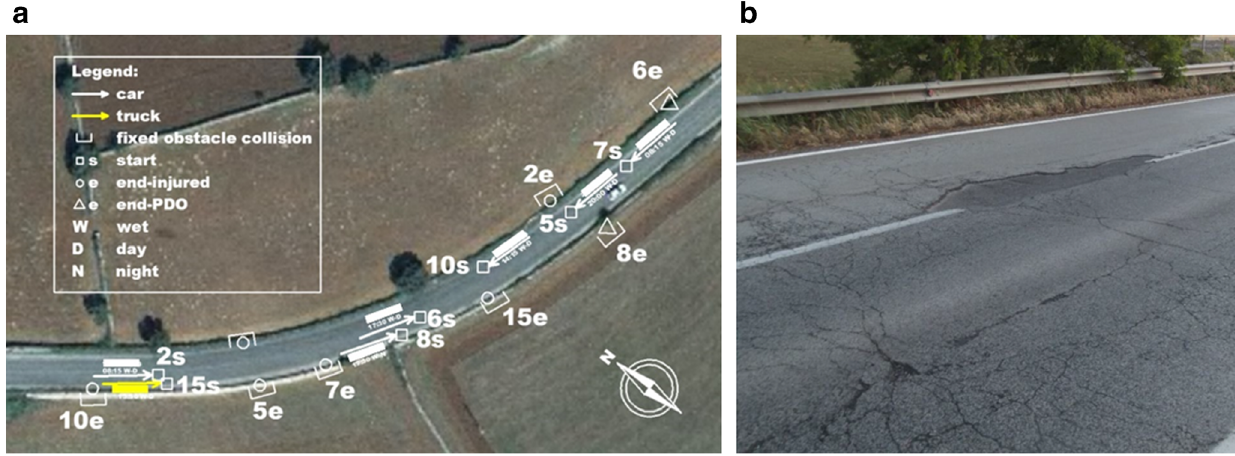
Fig. 6 Site PP1. a Collision Diagram of curve 3, b Example of deteriorated pavement along the road